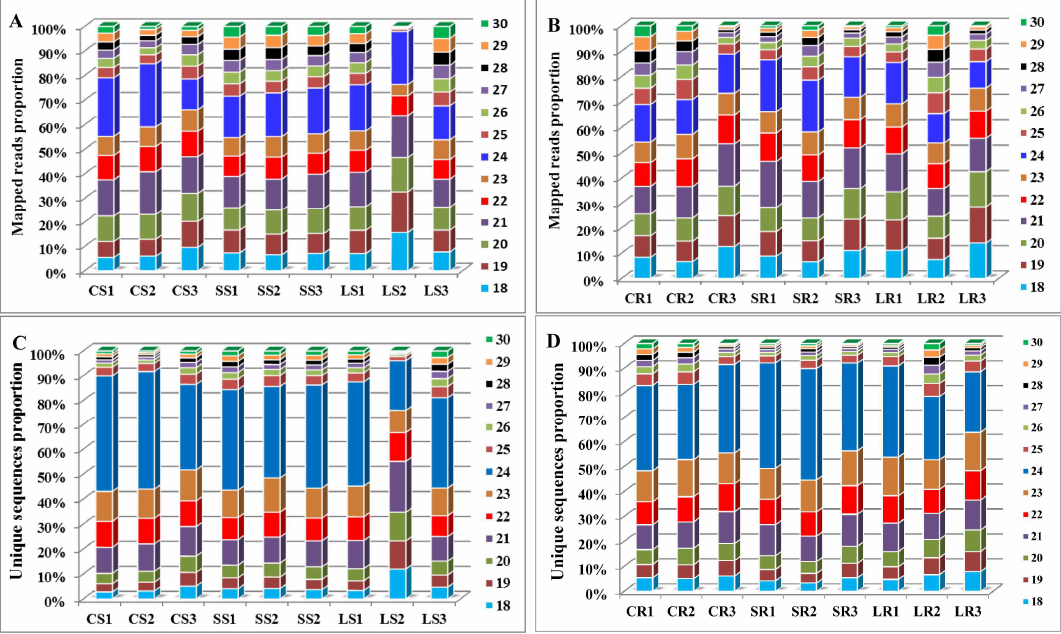
Figure 1. Length distributions of small RNAs identified in the roots and stem of P. euphratica . Size distribution of total mapped reads from the nine libraries of stems ( A ) and the nine libraries of roots ( B ). The distribution of stems ( C ) and roots ( D ) are based on the mapped unique reads.